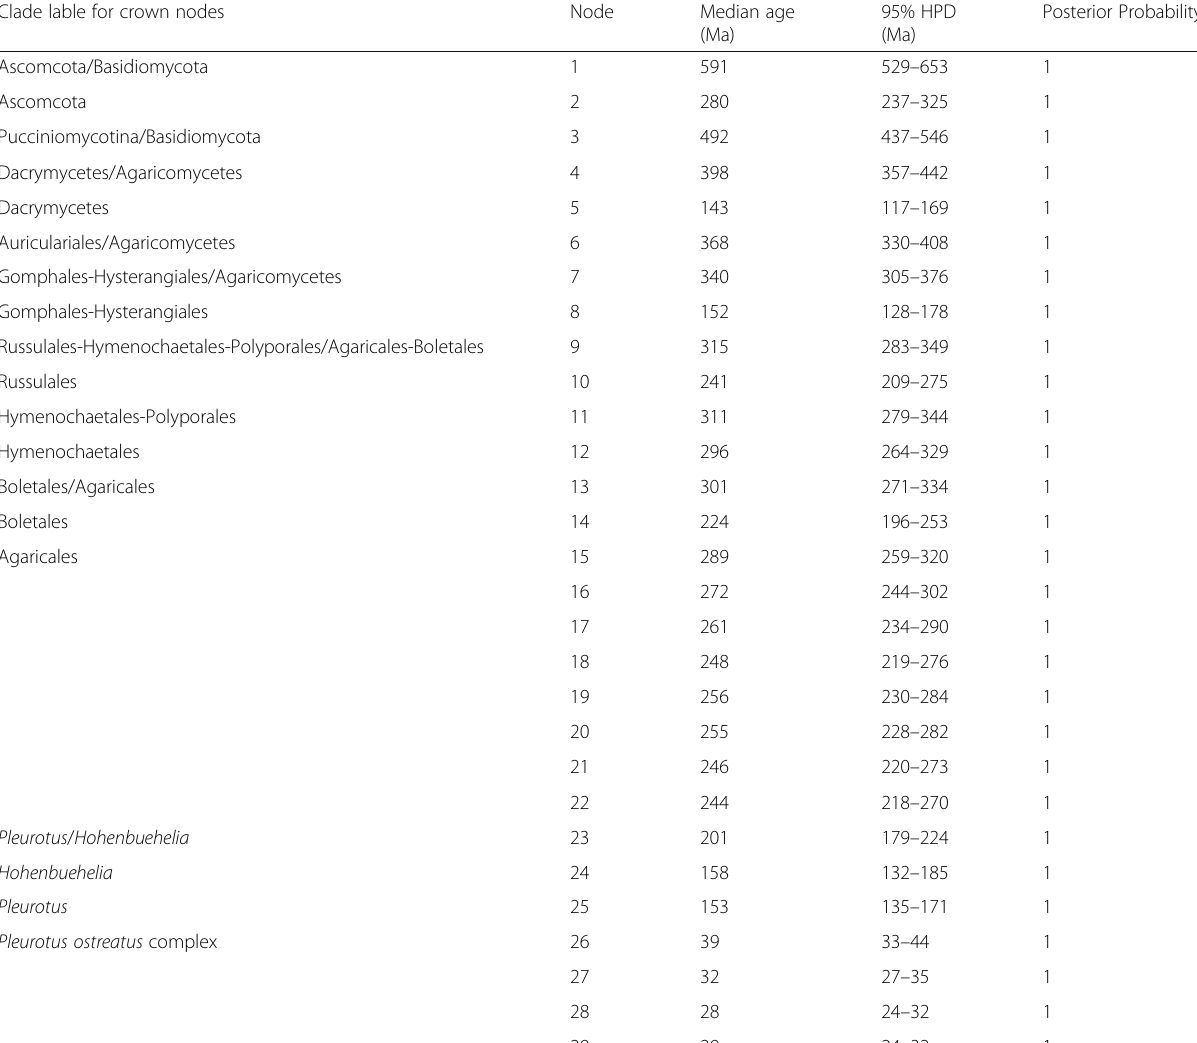
Table 2 Estimated node ages and 95% HPD (Ma) Clade lable for crown nodes